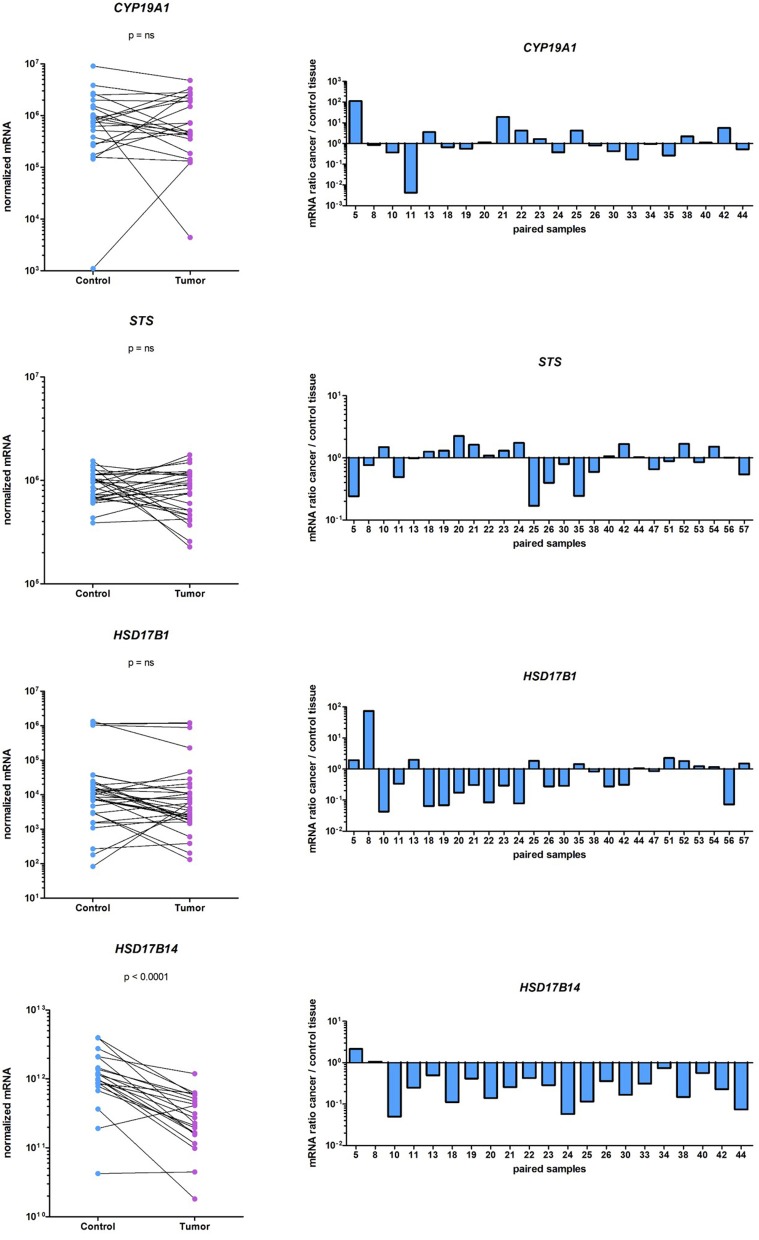
Expression of CYP19A1, STS, HSD17B1, and HSD17B14 in the EC and adjacent control tissues. On the left before-and-after graphs show the normalized expression levels of the genes investigated in control endometrium (Control) and the corresponding cancer endometrium (Tumor). The levels of gene expression are presented on a logarithmic scale. On the right are histograms with logarithmic scale shows mRNA ratio between cancer and control tissue.